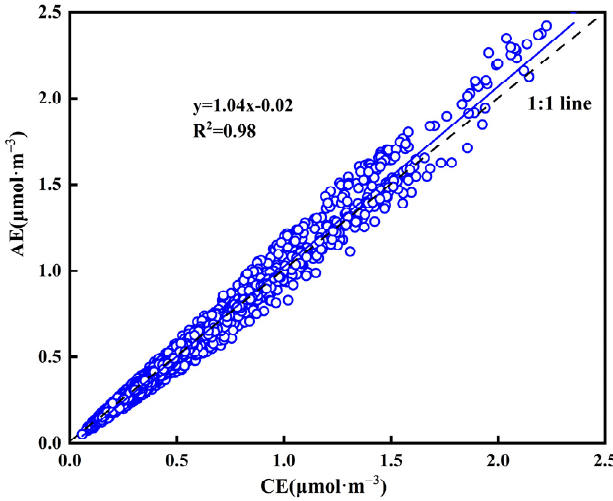
Figure 5. Charge balance between total cation equivalents and anion equivalents in PM 2.5